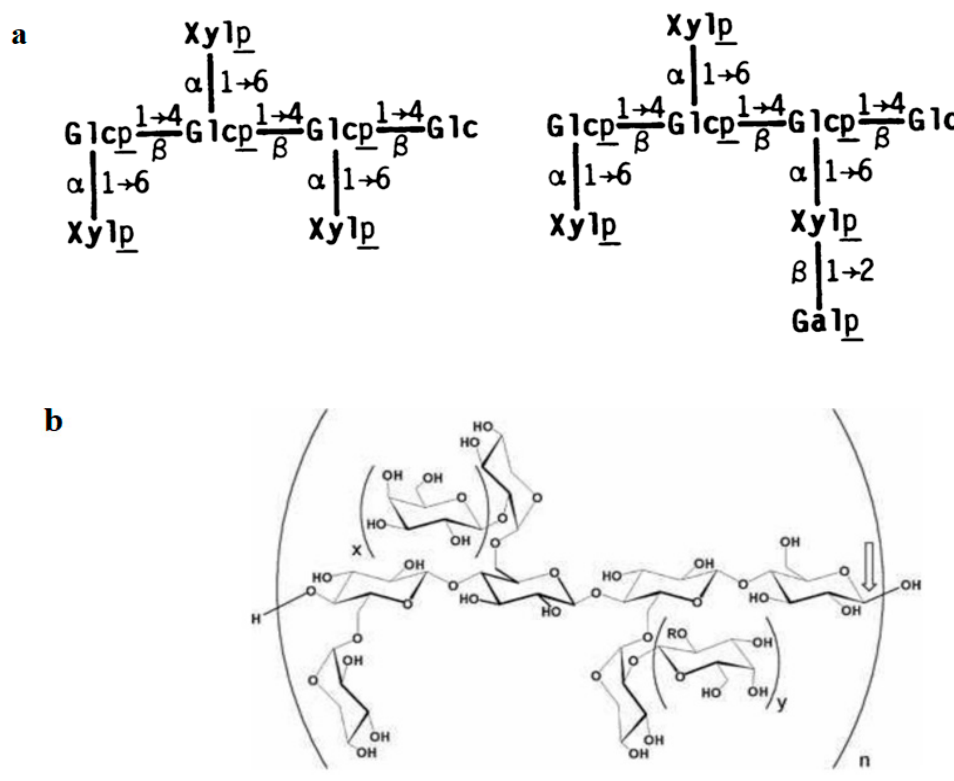
Figure 2. Composition of xyloglucan oligosaccharides extracted from the seed of the tamarind tree ( Tamarindus indica ). ( a ) Structures of xyloglucan. Structures shown are those reported for the quantitatively major oligosaccharides of each size-class isolated from cellulase-digests of xyloglucan [47]. ( b ) Configuration of xyloglucan. The configuration of xyloglucan gives the product a “mucin-like” molecular structure, thus conferring optimal mucoadhesive properties [46].